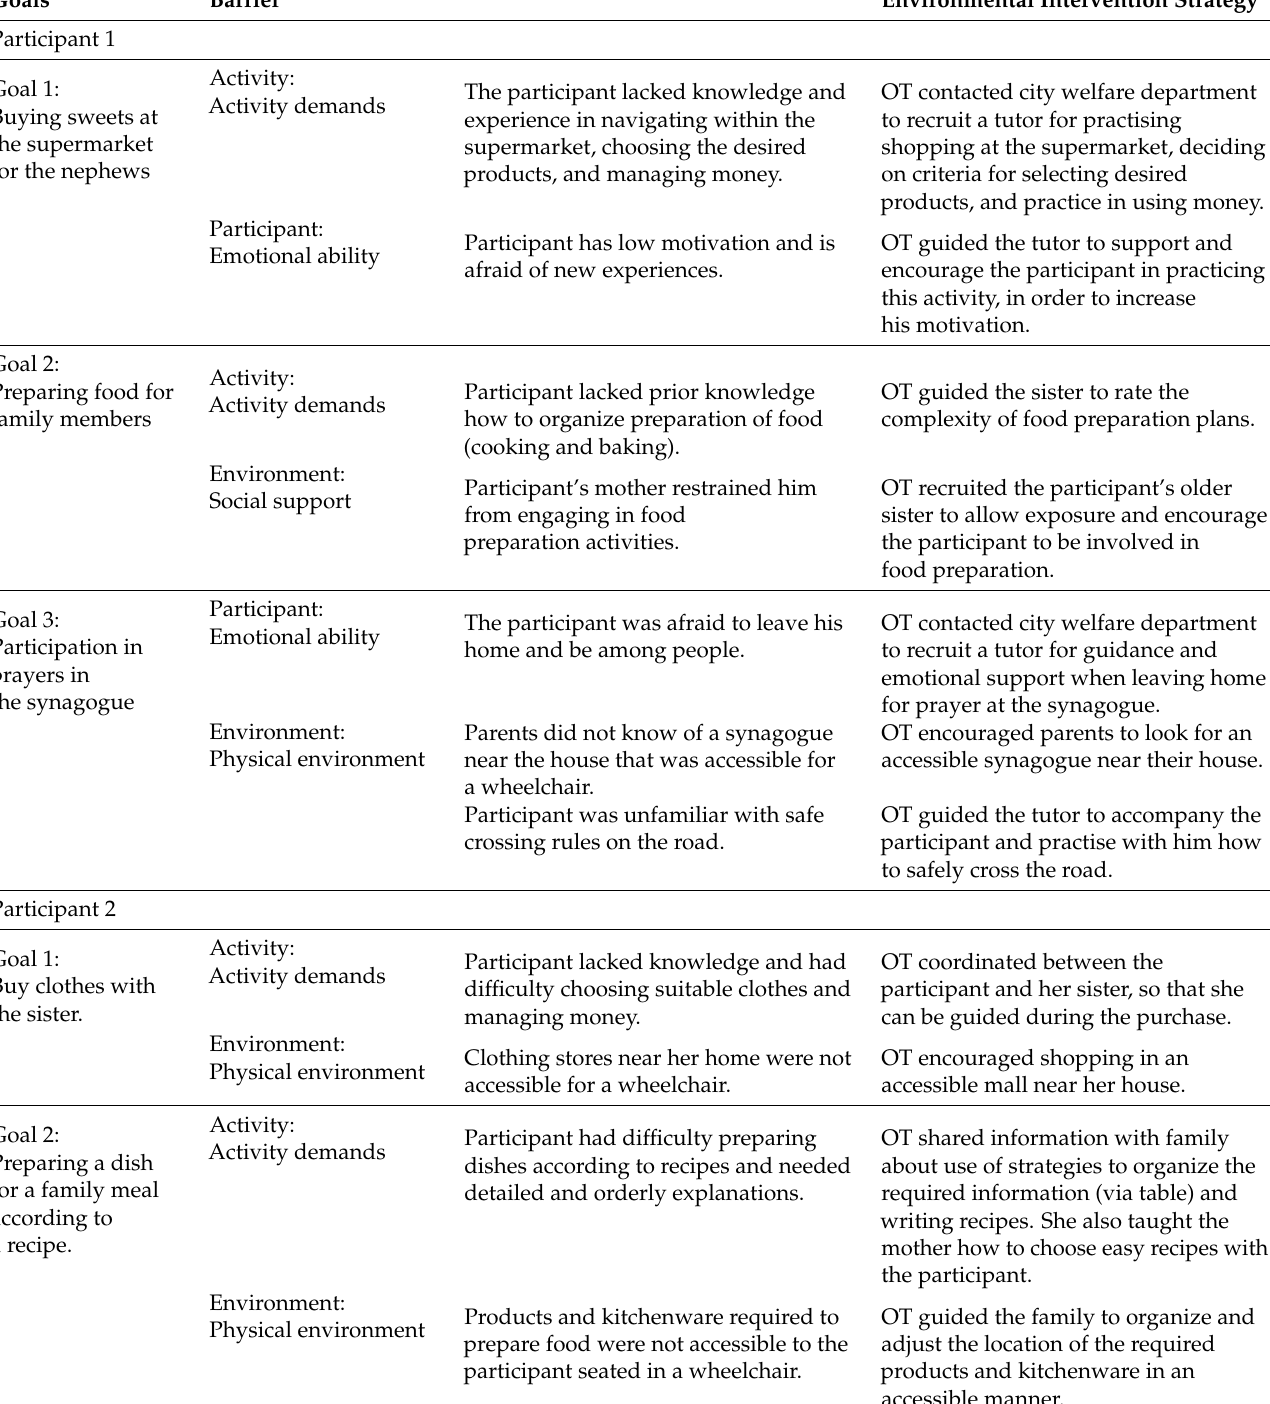
Table 1. Goals, examples of environmental barriers and intervention strategies for each